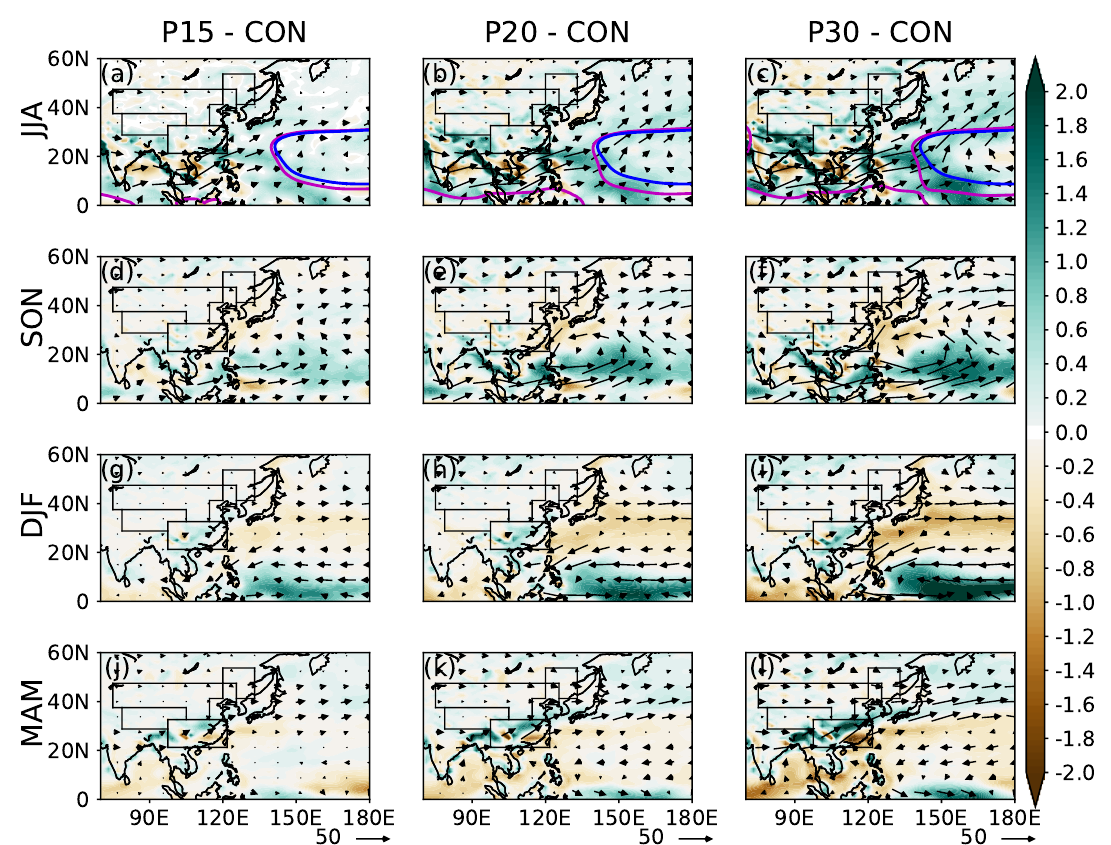
Figure 6. Same as Figure 5, but differences in seasonal-mean, vertically integrated moisture con- vergence (s − 1 ; shaded) with vertically integrated moisture transport (kg m − 1 s − 1 ; vectors). Eddy geopotential height at 500 hPa (0 m; contour; WNPSH index) for CON (blue) and respective warmer experiments (magenta) is only shown for ( a – c ) JJA, but not shown for ( d – f ) SON, ( g – i ) DJF, ( j – l ) MAM. The five regions are demarcated by the regional boundaries in